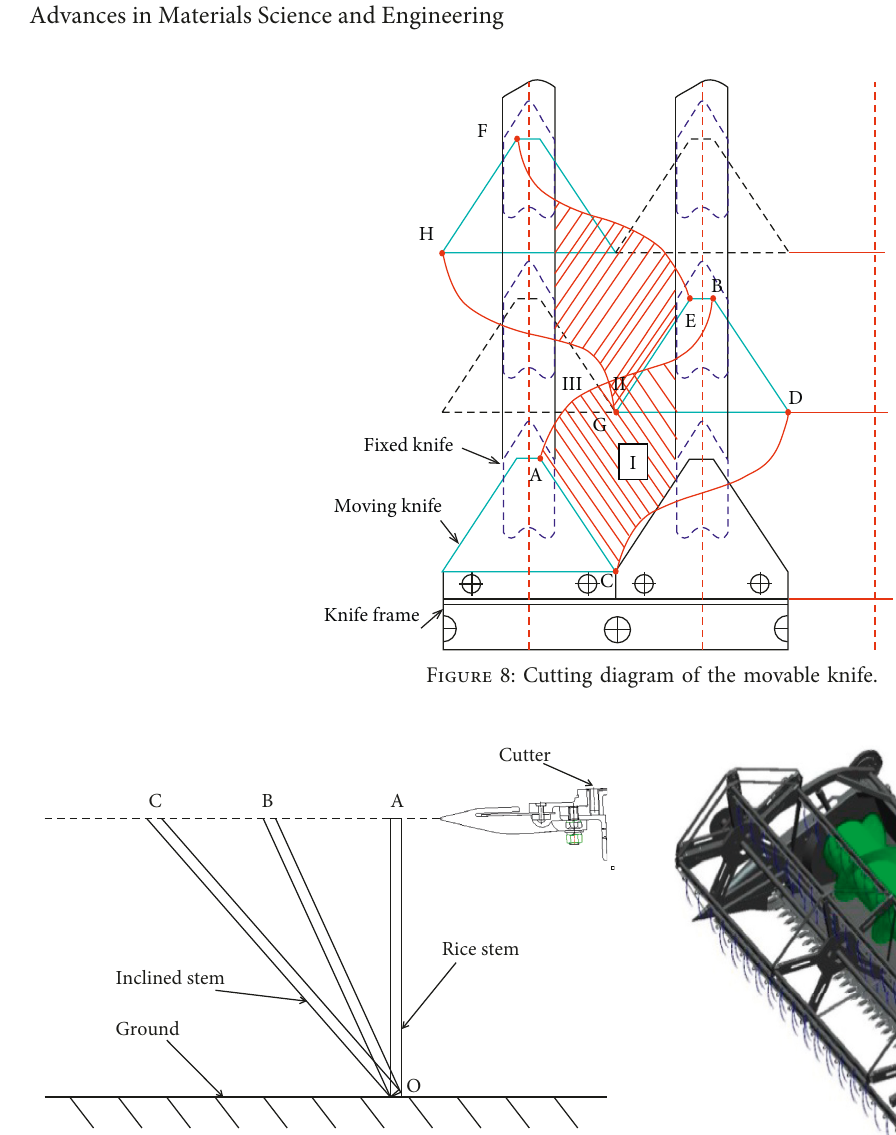
Figure 9: Stem oblique cutting